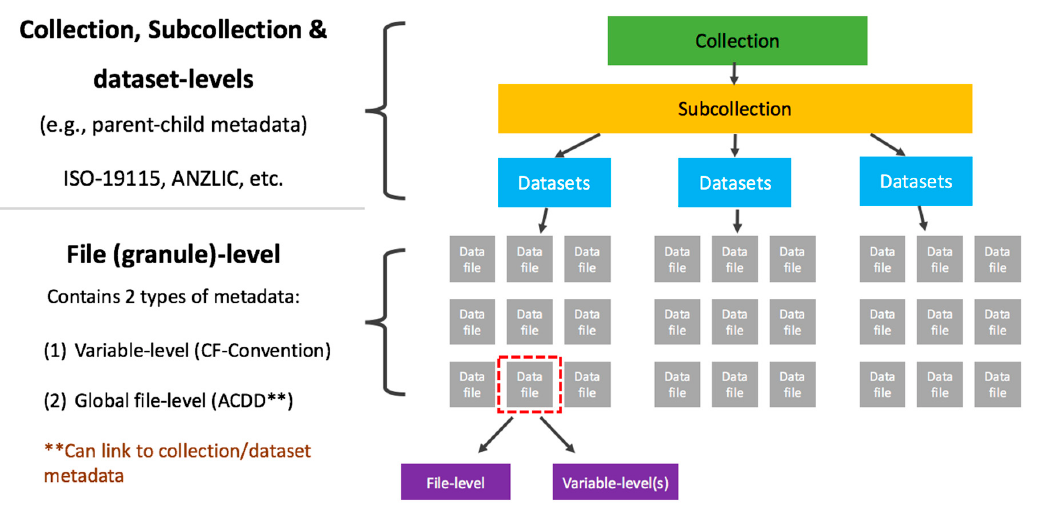
Figure 1. Illustration of the different levels of metadata and community standards used for each.